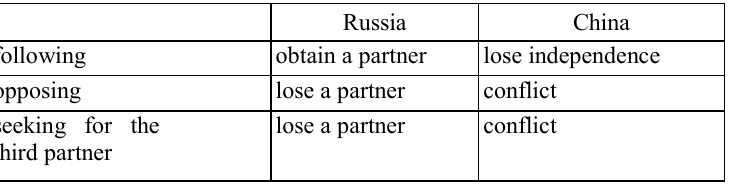
Table of Mongolian Strategy vies a vies two major players